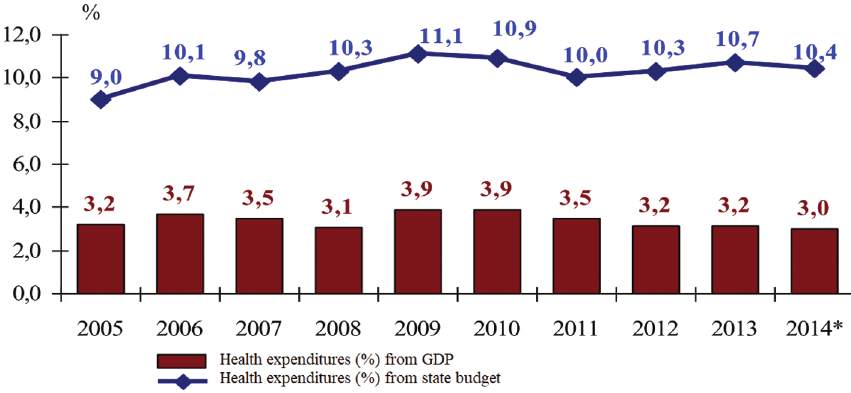
Figure 7. Expenditure on health from GDP and from the general state budget in Latvia, 2005–2014,%, from ([69], p. 82). *Draft budget as approved by the Saeima in the second reading for the 2014 budget of the Ministry of Health. Source: Renemanis, 2015, p.